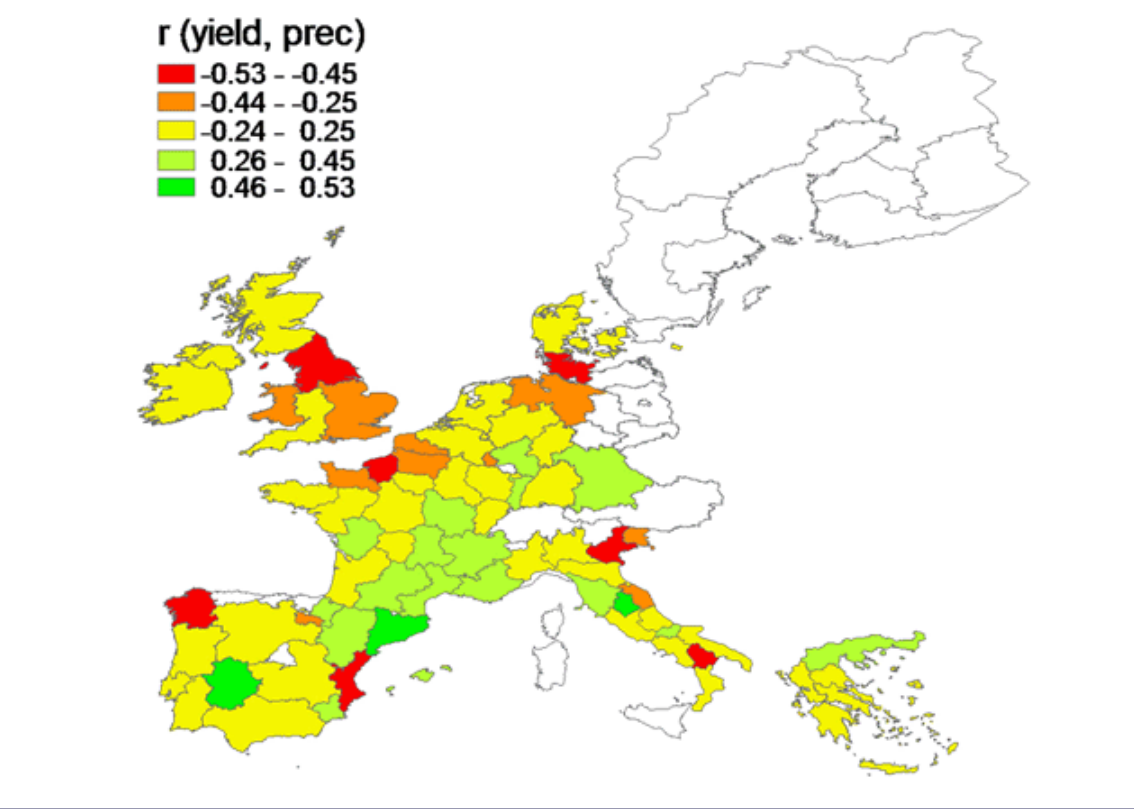
Fig. 3. Spatial distribution of the correlation between inter-annual variability in precipitation and wheat yield anomalies [r(yield,prec)]. The legend is different from Fig. 2 to demonstrate the (non-) significant relationships